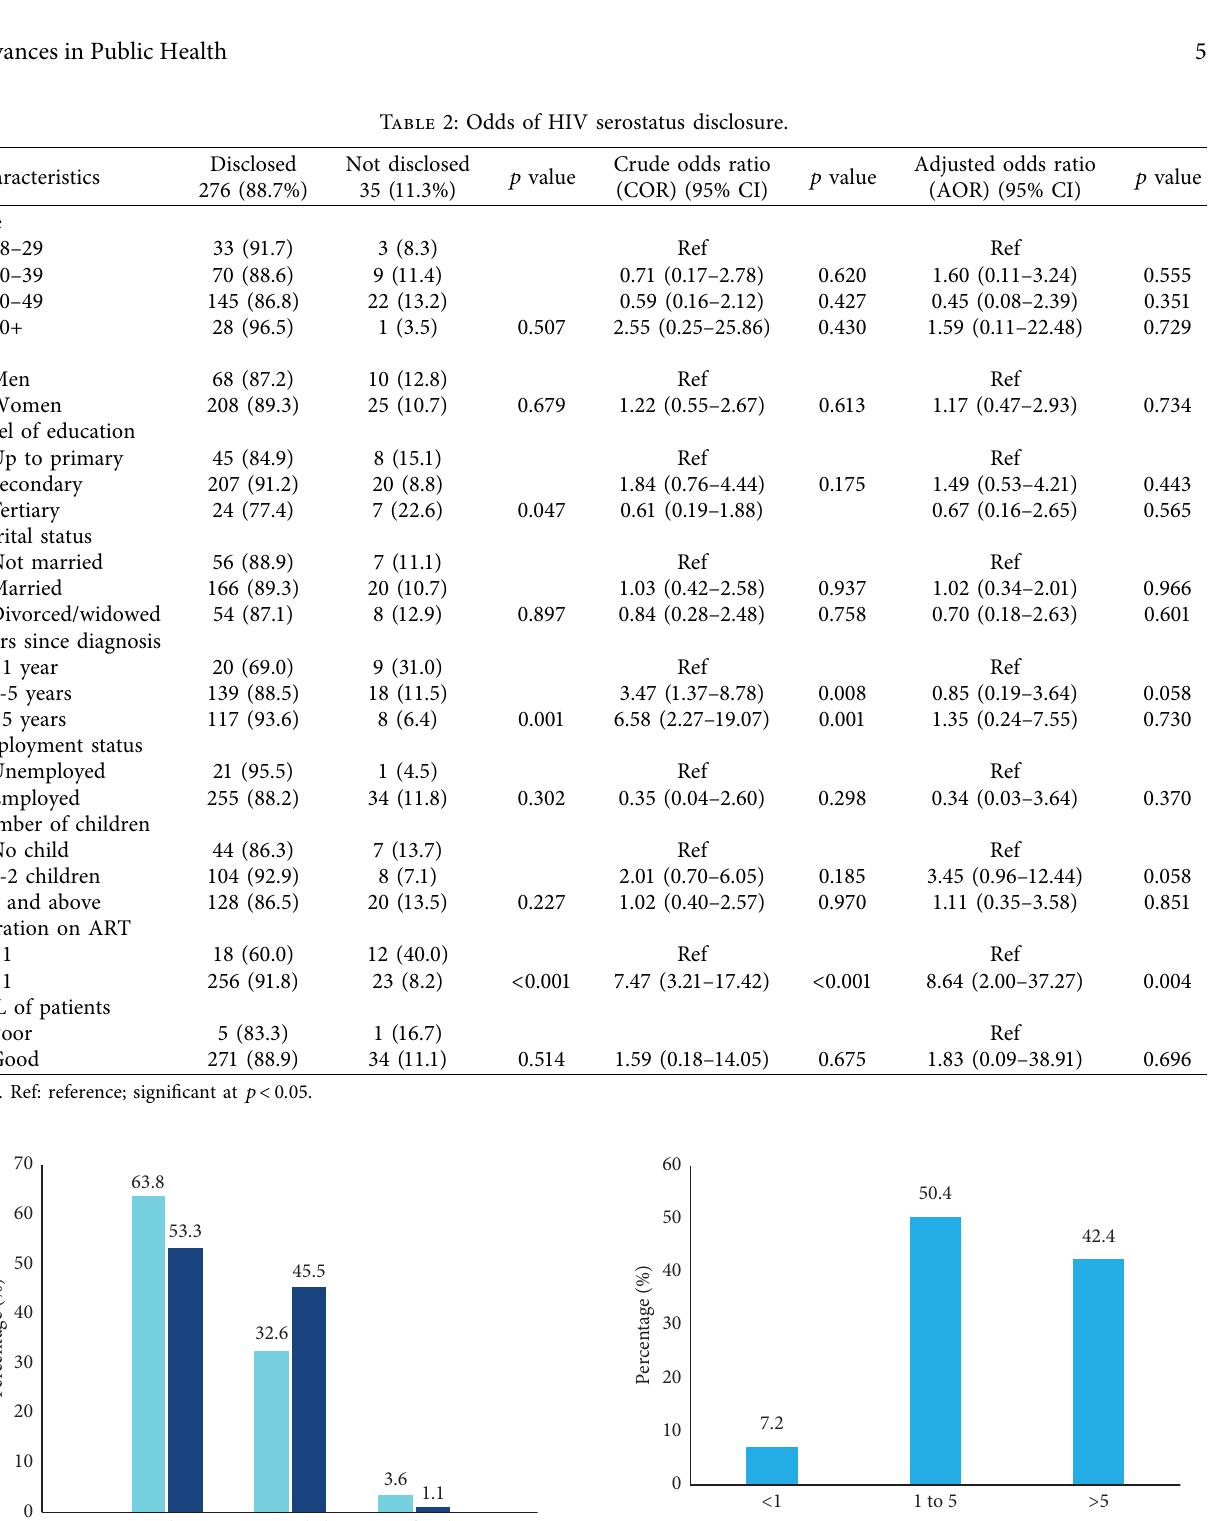
Figure 2: Disclosure of HIV status stratifed by years since di- agnosis ( p < 0 .